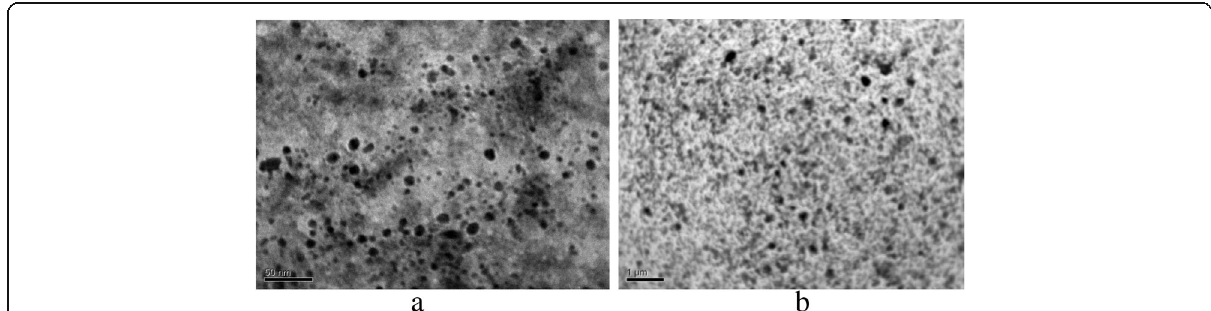
Fig. 3 TEM images of cation - exchanger of the second series. ZHP nanoparticles ( a ) and larger particles, a size of which is 100 – 300 nm ( b ), are